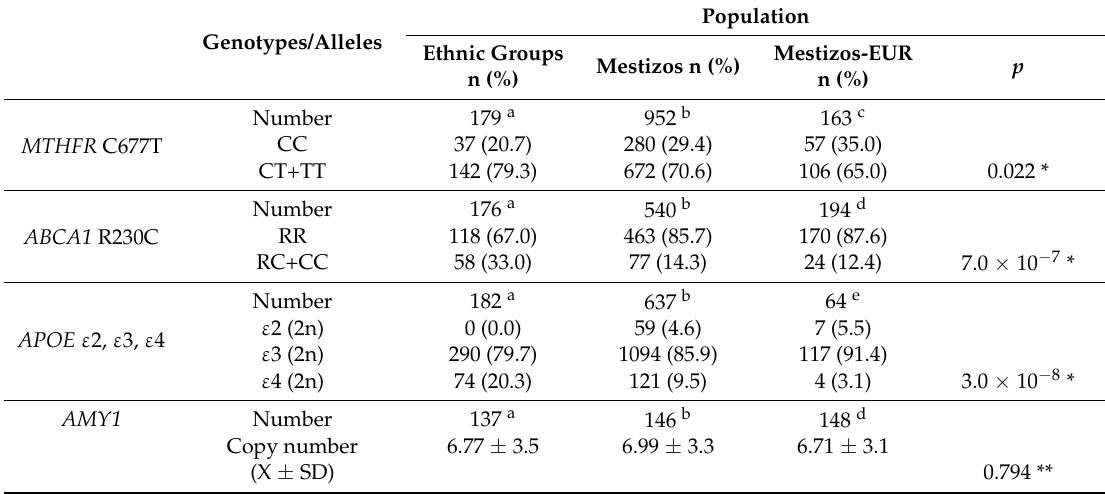
Table 2. Genotype frequency of DRAG polymorphisms in subpopulations of Central West Mexico Population Genotypes/Alleles Ethnic